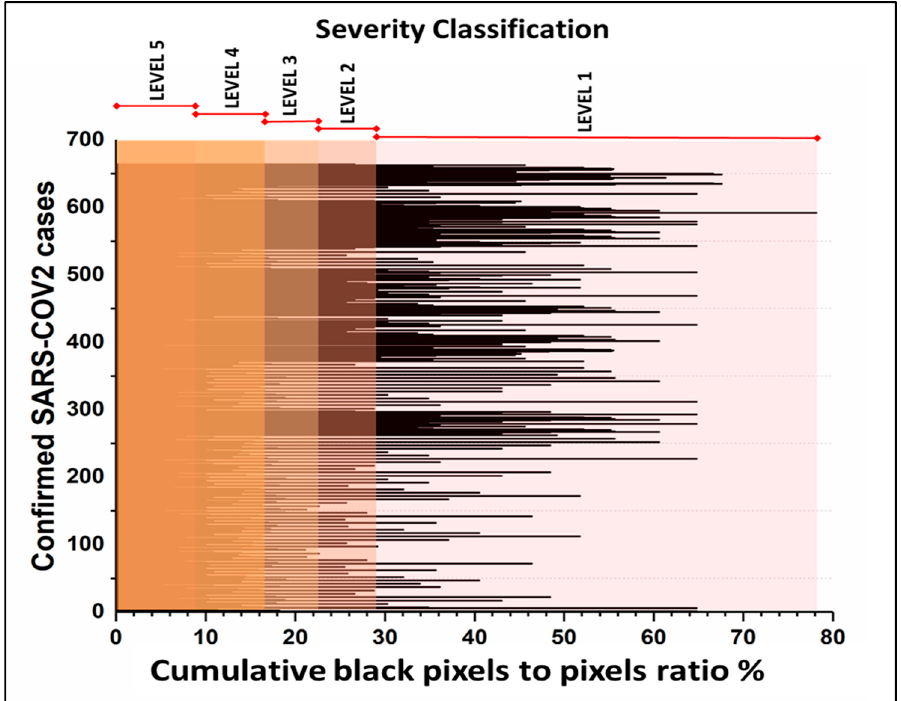
Figure 4. Classifications of severity by the prototype color-thresholding auto-detection method. The distribution of the data shows the ratio of cumulative black pixels to total pixels in the ROI. Table 1. Quantitative statistical evaluation for the outcome of the proposed model against radiolo- gists’ readings.